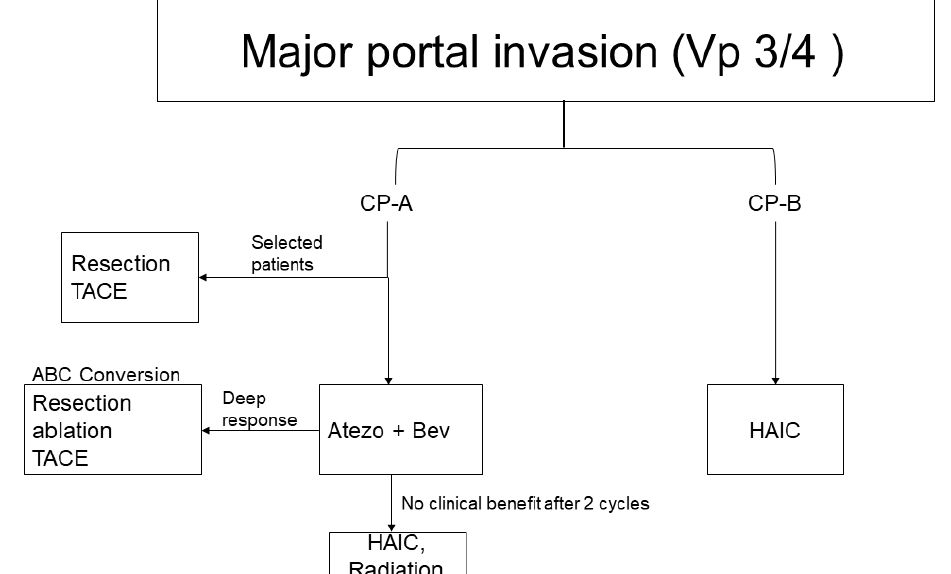
Figure 3. Treatment strategy for advanced HCC with major portal venous invasion. Atezolizumab plus bevacizumab combination therapy could be a first choice of treatment in patients with major vascular invasion and in patients with Child–Pugh class A liver function. Curative conversion can also be expected when deep response is achieved by atezolizumab plus bevacizumab combination therapy (ABC conversion). Vp3, tumor invasion to the first branch of the portal vein; Vp4, tumor invasion into the main trunk of the portal vein; HAIC, hepatic arterial infusion chemotherapy; ABC conversion, atezolizumab plus bevacizumab followed by curative conversion; TACE, transarterial chemoembolization; clinical benefit, AFP level and/or tumor size reduction.